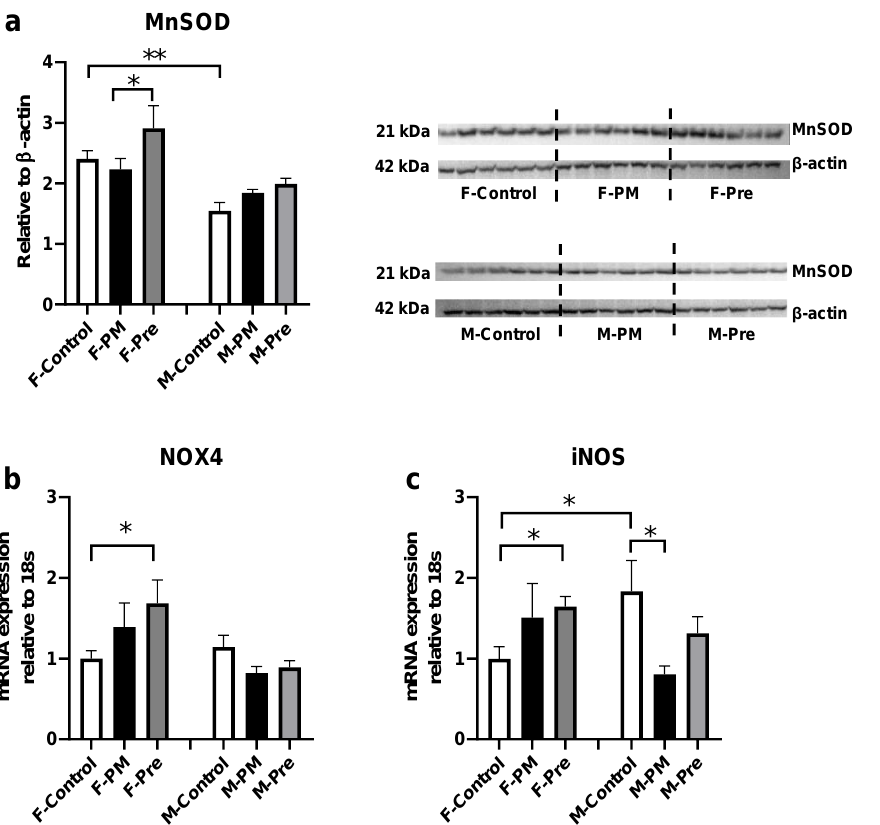
Figure 3. Oxidative Stress Markers in Female and Male Offspring. Protein expression levels of MnSOD ( a ) and mRNA expression levels of iNOS ( b ) and NOX4 ( c ). Results are expressed as mean ± SEM, n = 6. * p < 0.05; ** p < 0.01. iNOS: inducible nitric oxide synthase, MnSOD: manganese superoxide dismutase, NOX4: NADPH oxidase 4. PM: offspring from dams continuously exposed to PM2.5; Pre: offspring from dams exposed to PM2.5 before conception only.